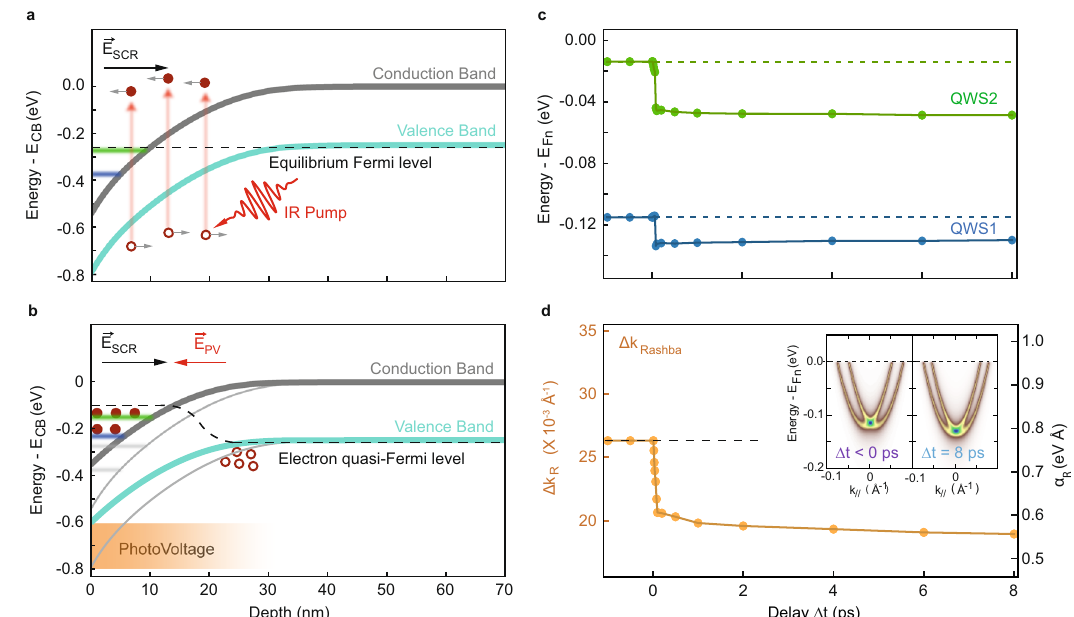
Fig. 4 Simulations of the band bending and quantum-well state dynamics. a Band-bending pro fi le for a surface biased p-doped Bi 2 Se 3 ; the surface boundary condition V 0 is given by the shift of the Dirac point after potassium evaporation, and the bending is calculated solving the Poisson equation within a modi fi ed Thomas-Fermi approximation. The energy minima of QWS1 and QWS2 are solutions of the Schrödinger equation within the con fi ning potential, and well reproduce experimental observations. At zero-delay, an optical excitation creates free electron-hole pairs that are swept apart by the built-in electric fi eld of the space-charge region, E SCR . b After 8 ps the charge separation between electrons and holes generates a photovoltage whose electric fi eld ( E PV ) opposes E SCR and softens the band bending, causing the QWSs to shift upwards. Concomitantly, the increasing surface electron density shifts the E Fn upwards. c The calculated energy minima of QWS1 and QWS2 with respect to E Fn are obtained from a time-dependent calculation of the band bending and QWSs' energy levels; the observed decrease at time zero is given by the change of the electrostatic environment and carrier redistribution across SCR. d The simulated Rashba momentum splitting ( Δ k R ) at the Fermi level for QWS1; the Rashba strength α R is given on the right axes. The photovoltage- induced reduction of the surface electric fi eld in the system is responsible for the decrease of α R and Δ k R . Inset: Simulated spectral functions of QWS1 before and 8 ps after the pump excitation, constructed from the results of the dynamical simulation. The simulated data con fi rms the two main observation from the TR-ARPES experiment, an increase in electron population accompanied by a decrease in the